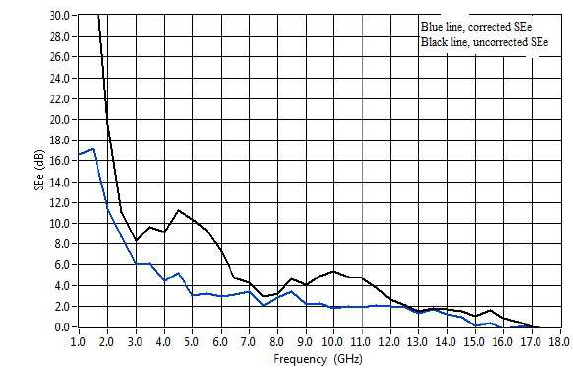
Figure 6: SE e from measurements of 1 mm mesh size enclosure.